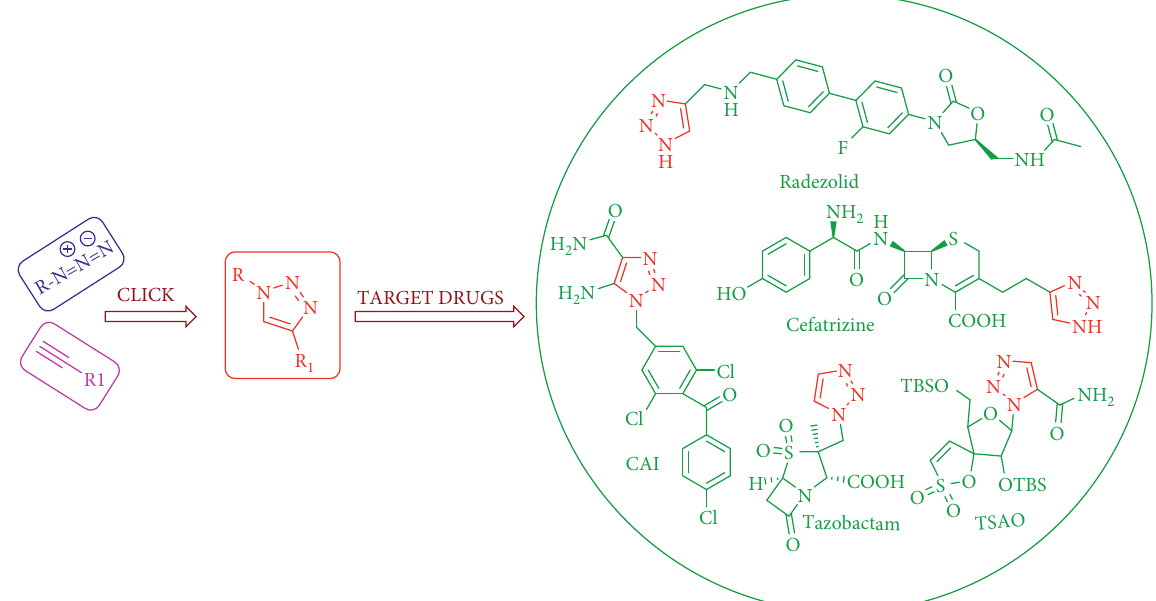
Scheme 9: Chemical structure of 1,2,3-triazole-based marketed drugs.